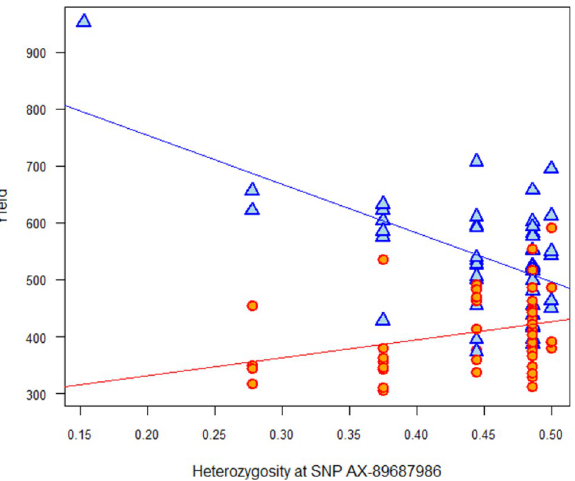
(red points and line) and in blue negative effect (ns) under Rain-fed conditions.